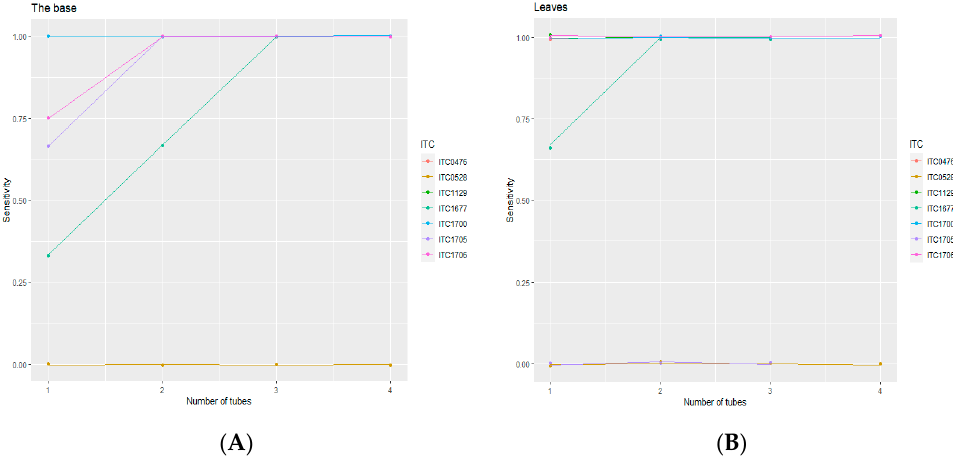
( A ) ( B ) Figure 3. Diagnostic sensitivity of the test detecting BanMMV from two different in vitro tissues using combinations of plants per accession: ( A ) from the base (corm + meristem); ( B ) from leaves. Table 4. HTS results of BanMMV detection from RNA extracts of the base or the leaves of in vitro plants. The number of reads per sample ranged between 6,499,298 and 10,357,840. + and − mean BanMMV detected or not detected